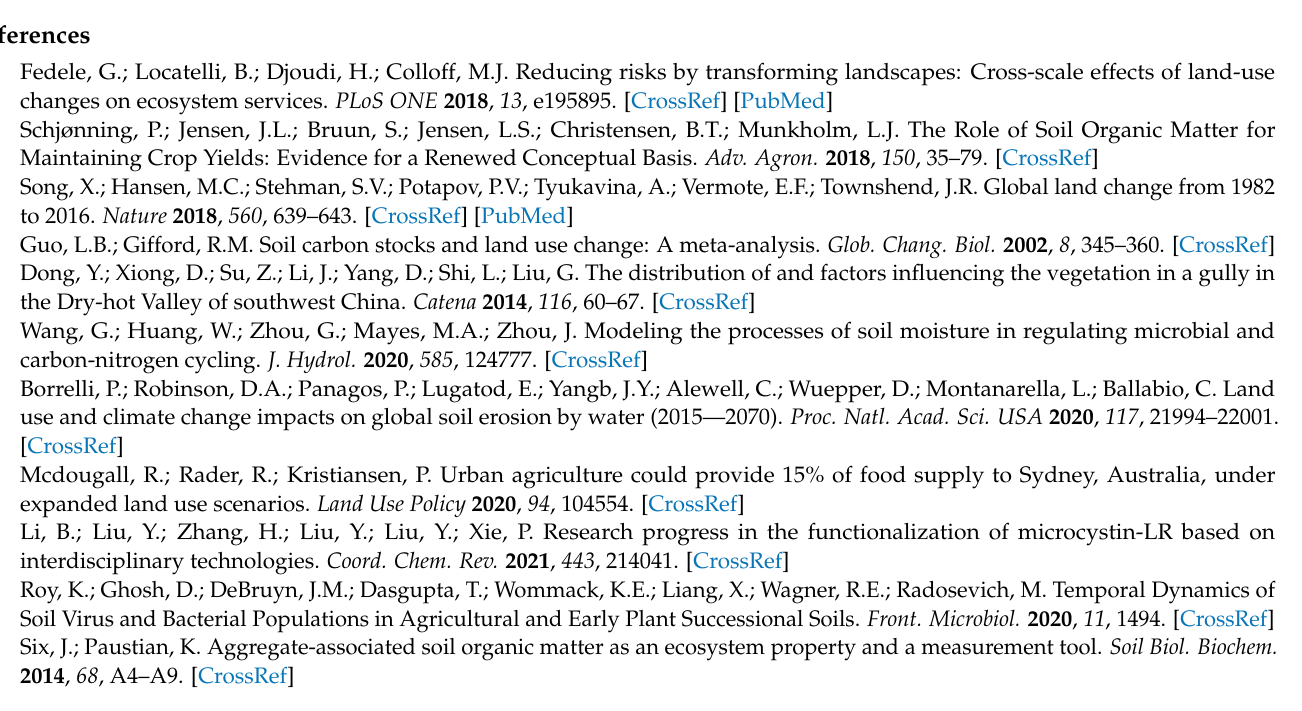
Figure S1. Rarefaction curves of 16S rRNA (A) and ITS (B) sequencing data in four land-use